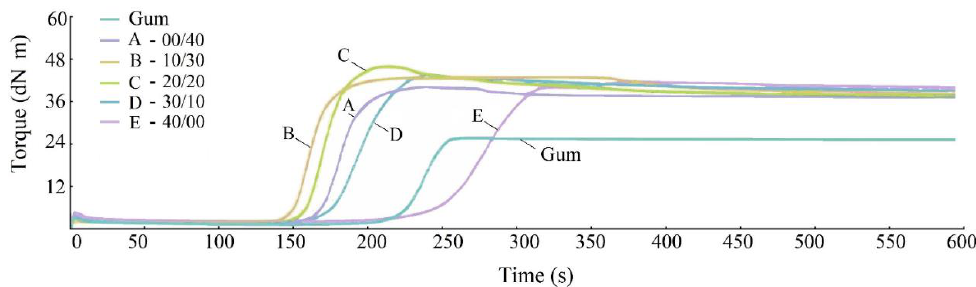
Figure 6. Rheometric curve (with 1 ◦ of disk oscillation and isotherms at 150 ◦ C) of the hybrid com- posites of NR with silica (SiO 2 + Si69 ® ) and calcium carbonate (CaCO 3 ) treated with 2% Chartwell ® . Gum was included as a reference point. Table 4. Rheometric properties (with 1 ◦ of disk oscillation and isotherms at 150 ◦ C) of the hybrid com- posites of NR with silica (SiO 2 + Si69 ® ) and calcium carbonate (CaCO 3 ) treated with 2% Chartwell ® . Gum was included as a reference